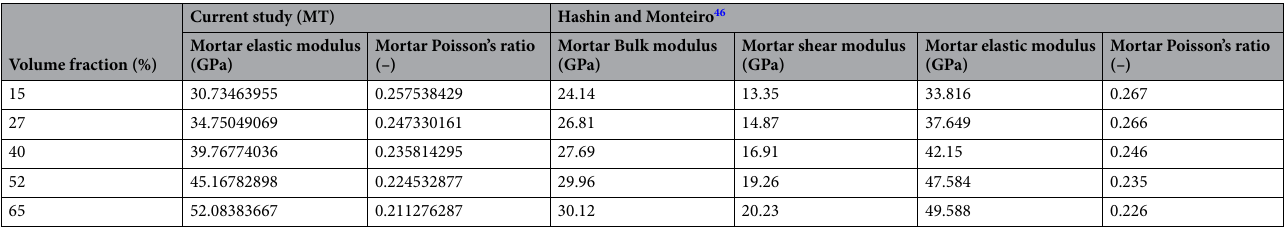
Table 5. Comparison of the experimental and measured elastic properties of mortar at different sand volume fractions.